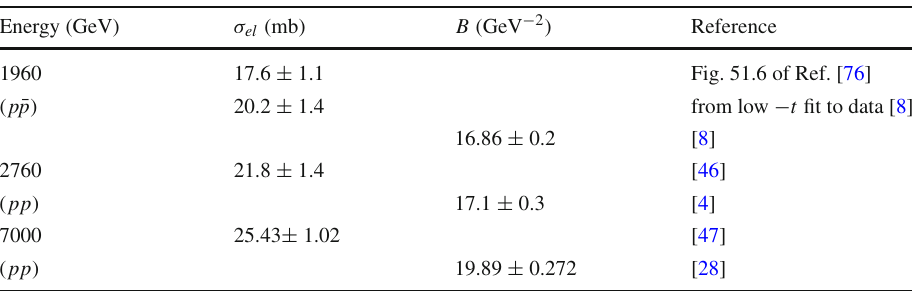
Table 1 Summary table of the elastic cross-sections σ el , the nuclear slope parameters B , and their sources or